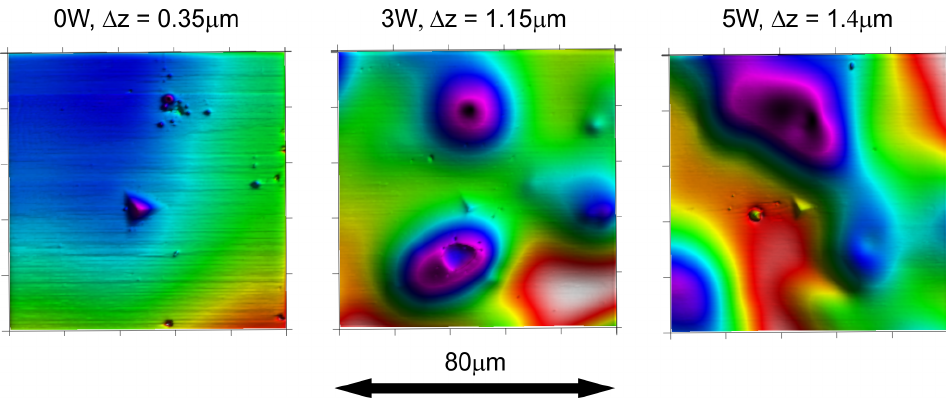
Figure 2. Gradual change of coating’s surface measured by Scanning probe microscopy mode in nanoindenter. Color coded vertical scale changes from image to image, thus height difference between the lowest and highest point is given.